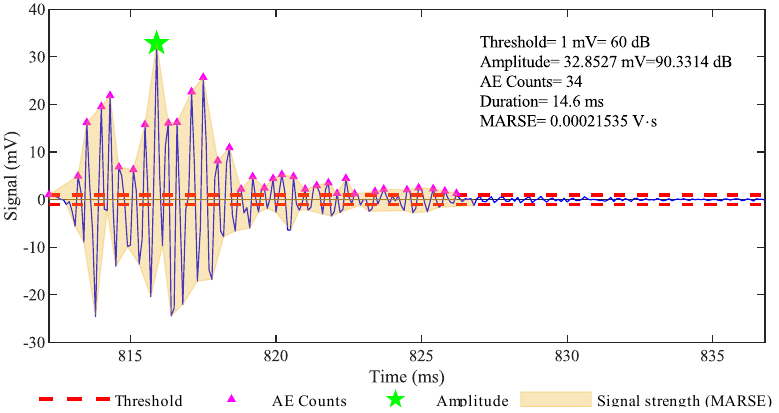
Figure 2. AE signal and parameters expressed in the time-domain.